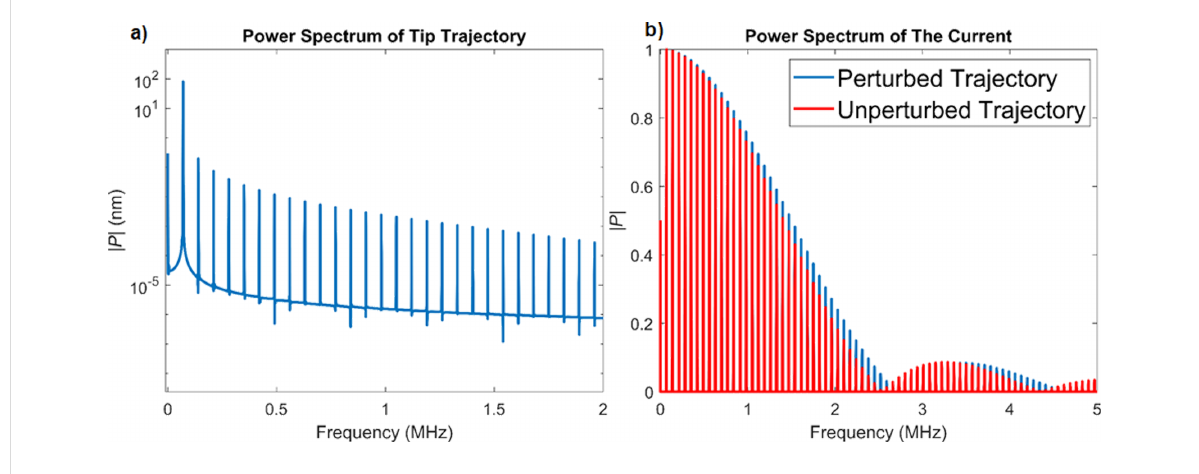
Figure 8: a) Power spectrum of the tip trajectory for the realistic simulation with the Hertzian repulsive interaction (the simulation parameters are pro- vided in Table 2). The higher harmonic amplitudes of the tip oscillation are much smaller than the first harmonic amplitude but do nonetheless influ- ence the current response. b) Comparison of the power spectrum of the current for the realistic numerical simulation with the power spectrum of the unperturbed, single-cosine trajectory. The single-cosine trajectory is designed to have the same frequency and maximum indentation as the realistic trajectory. Although the higher-harmonic amplitudes in the realistic tip trajectory are quite small compared to the first harmonic amplitude (a), the spectra of the current differ for the two trajectories considered. Both spectra exhibit the expected sinc envelope shape, with the envelope being wider when the realistic tip trajectory is considered.